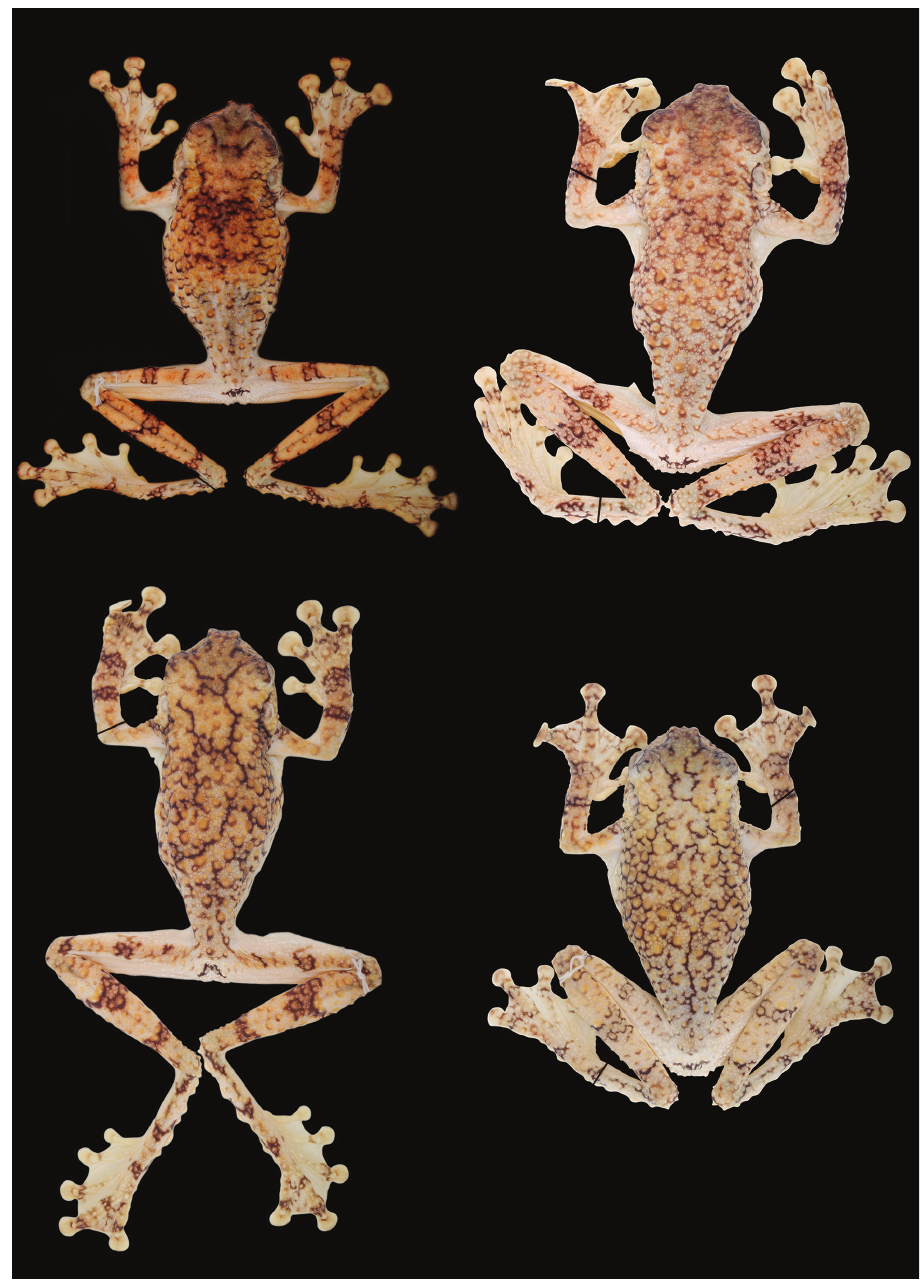
Figure 5. Variation in dorsal coloration of preserved specimens of adult Tepuihyla tuberculosa comb. n. Left to right, upper row: QCAZ 52855 (male), QCAZ 53542 (male); lower row: QCAZ 53147 (male), QCAZ 55423 (male). See Suppl. material 2 for locality data. Specimens are shown at the same